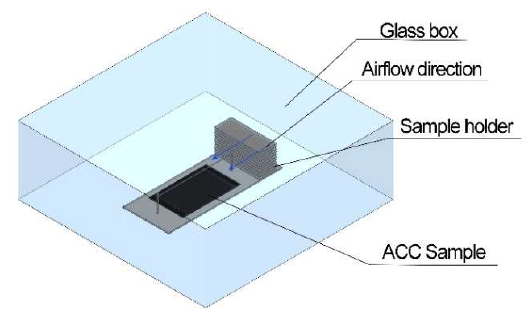
Figure 5. Schematic representation of the reactor.